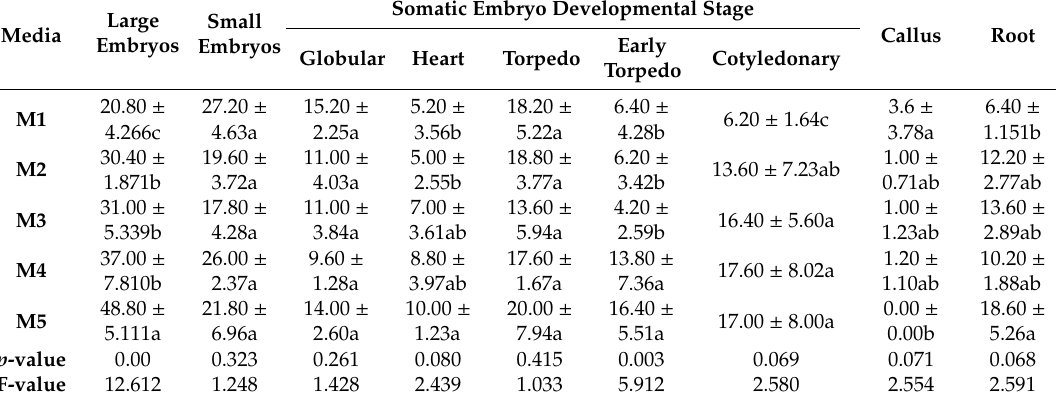
Table 2. Comparison of embryo size classes, somatic embryo (SE) developmental stage, number of SEs with callus formation at the base, and number of SEs that formed roots in M1–M5 media after 8 weeks of subculture. All values are means ± SD.